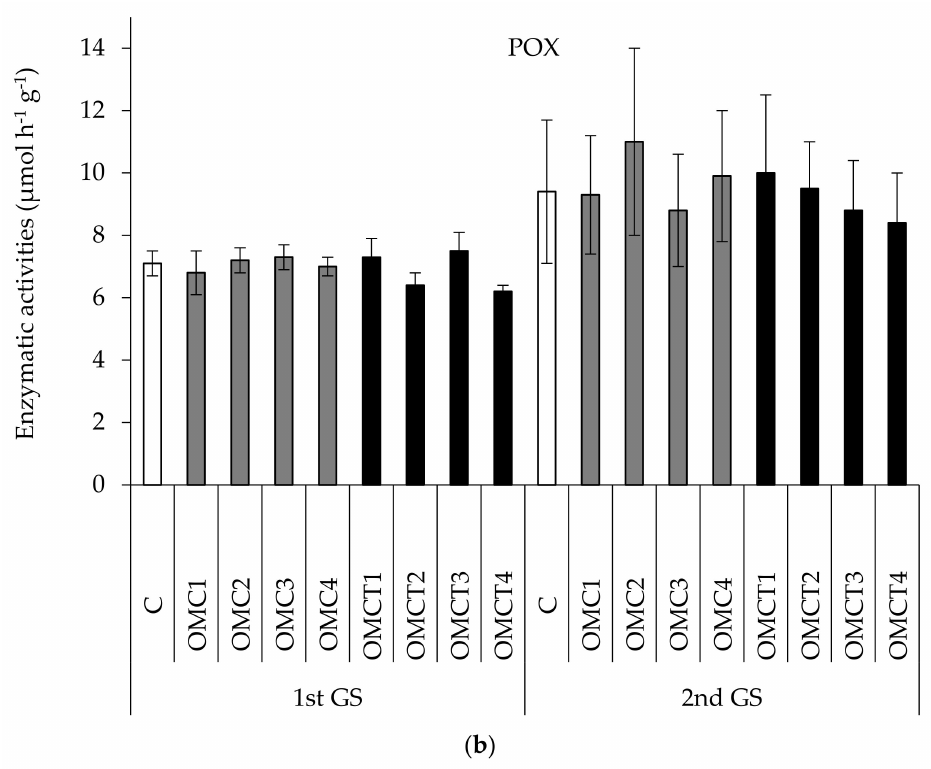
Figure 3. Mean ( a ) Soil respiration (mg CO2 h − 1 kg − 1 ) and ( b ) Enzymatic activities per gram of dry soil ( µ mol h − 1 g − 1 ) in two consecutive growing seasons. C = control; OMC= on-ion-manure compost; OMCT = onion-manure compost tea BG = β -Glucosidase, AP = acid phosphomonoesterase, LAP = leucine-aminopeptidase, POX = phenol oxidase activity. 1st GS = 2014–2015 growing season; 2nd GS = 2015–2016 growing season. Error bars = standard